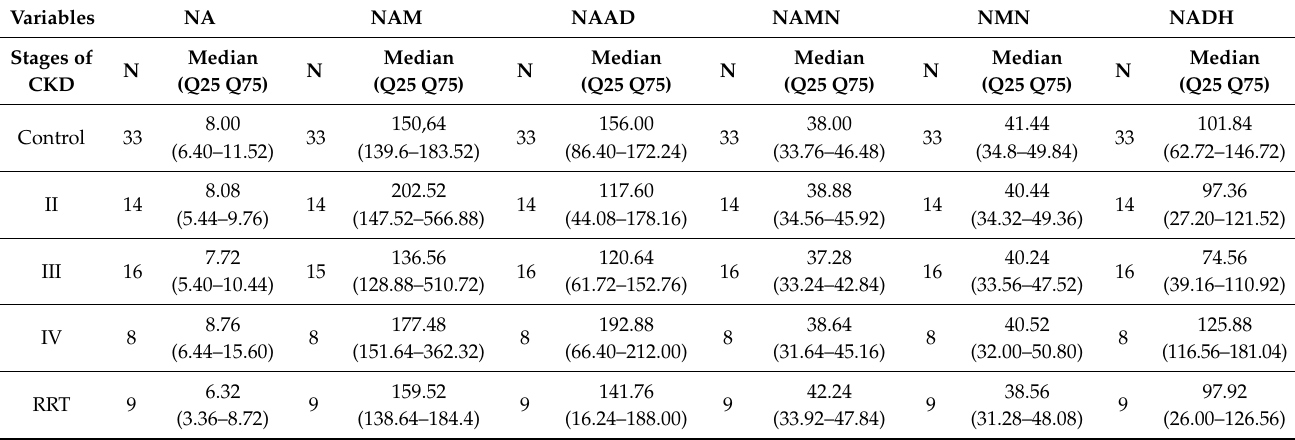
Table 5. Median of NA, NAM, NAAD, NAMN, NMN and NADH concentration values for individual stages of CKD and control group